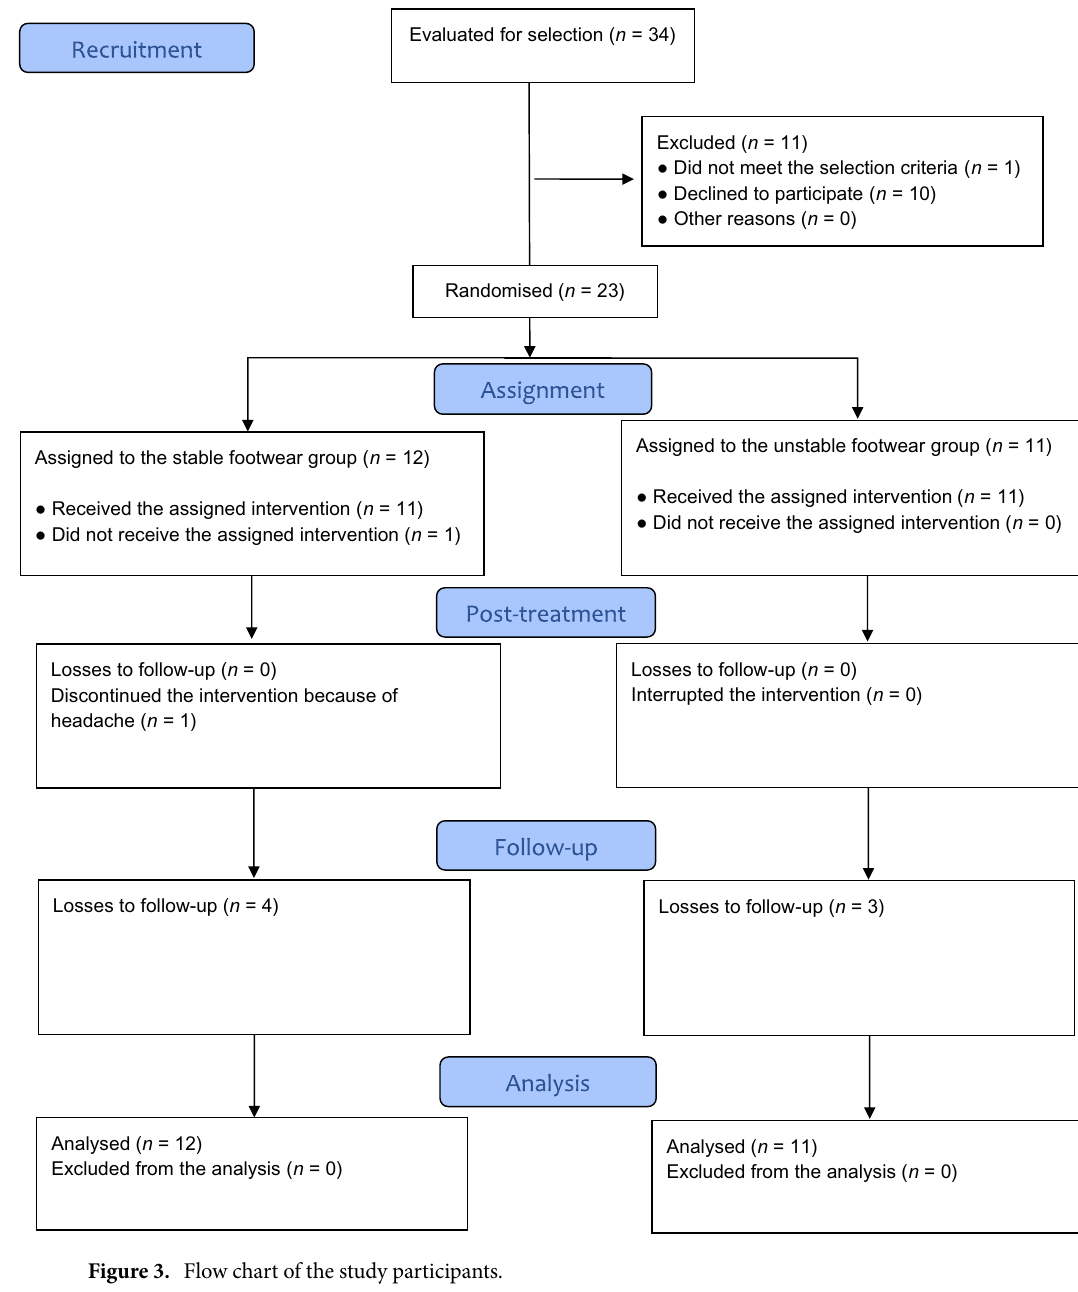
Figure 3. Flow chart of the study